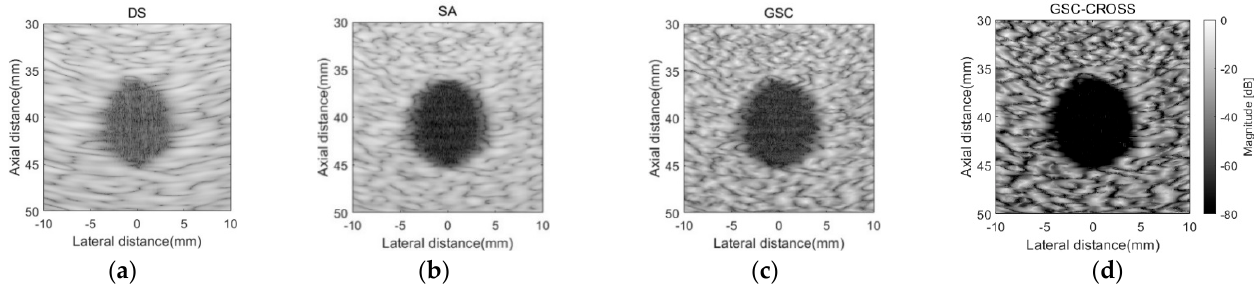
Figure 5. Contrast of beamforming responses for different beamforming algorithms. ( a ) DS; ( b ) SA; ( c ) GSC (L = 32, Δ = 20); ( d ) GSC-CROSS (L = 32, Δ = 20). The dynamic range of image is 80 dB.